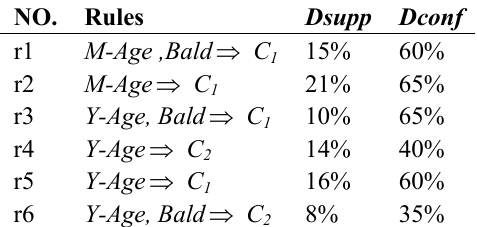
Table 9: Example of